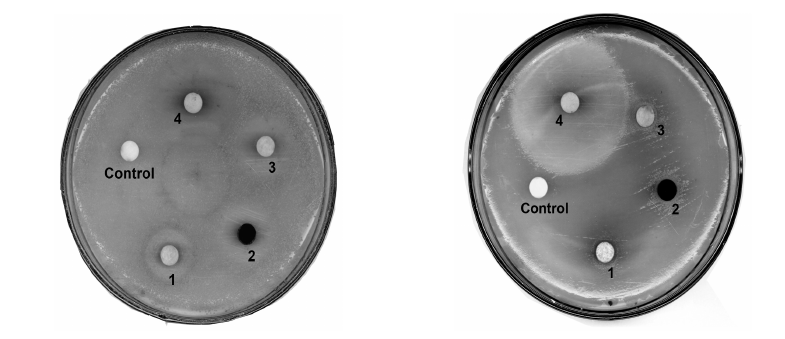
Figure 5. Antimicrobial activity